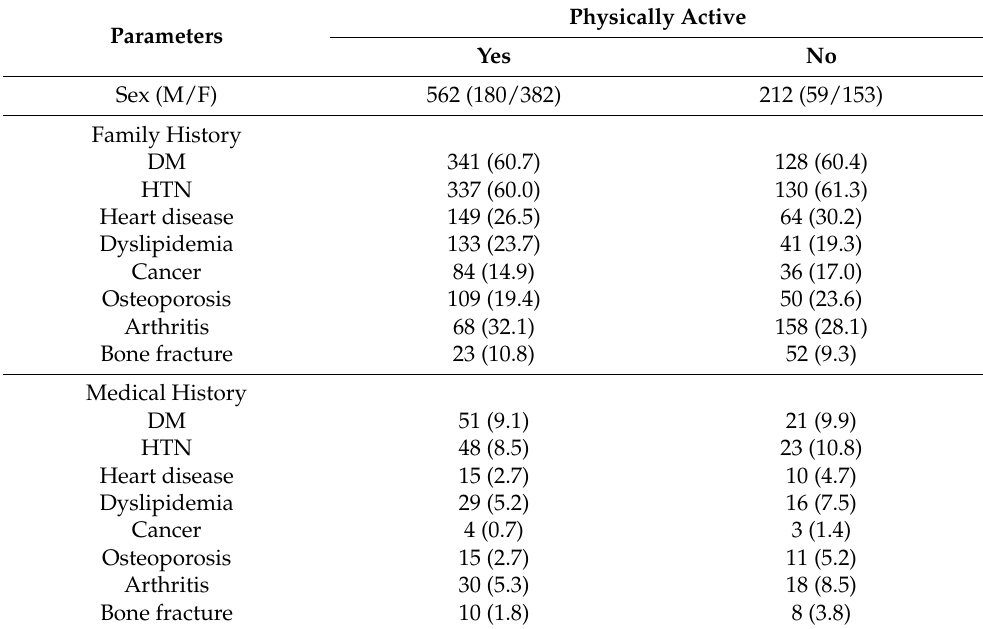
Table 2. Frequency of family history related to